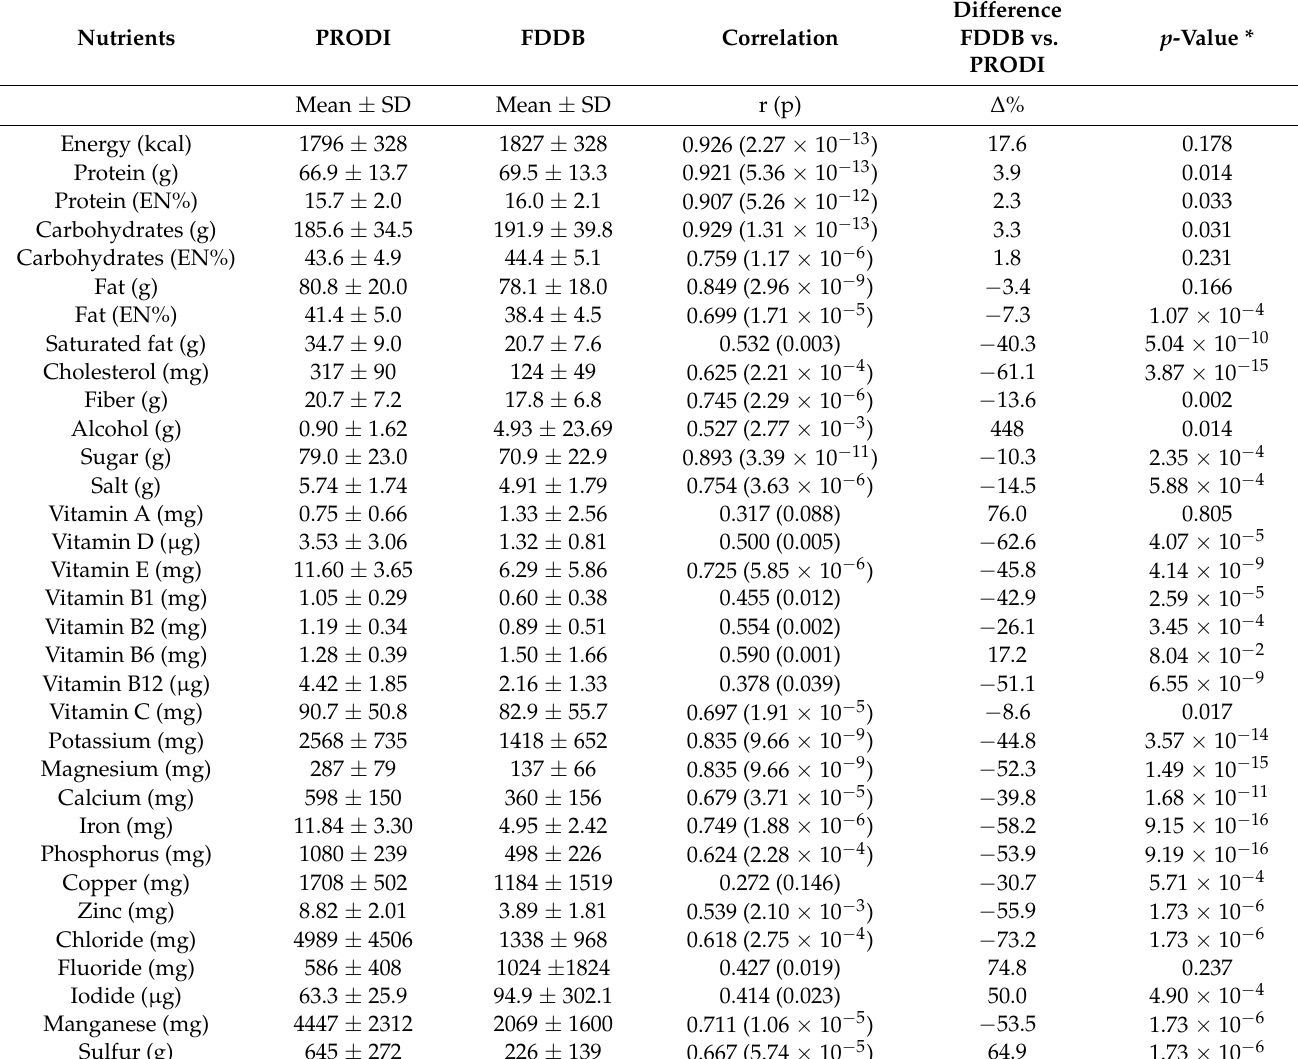
Table 2. Daily energy and nutrient intakes analyzed using the PRODI ® and FDDB